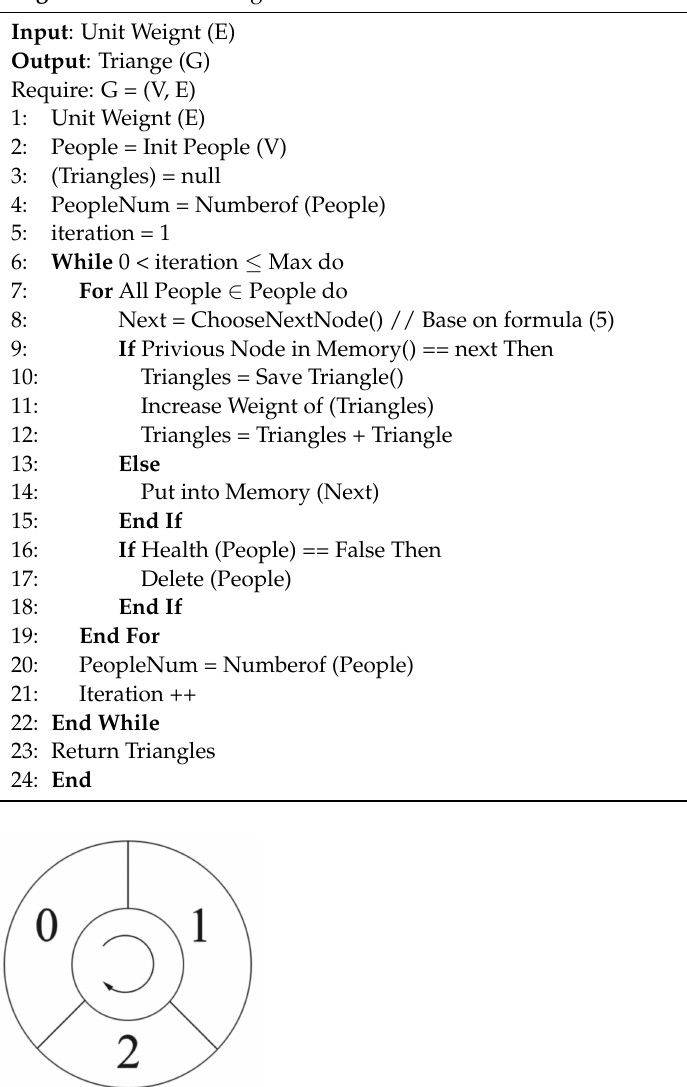
Figure 3. The structure of human